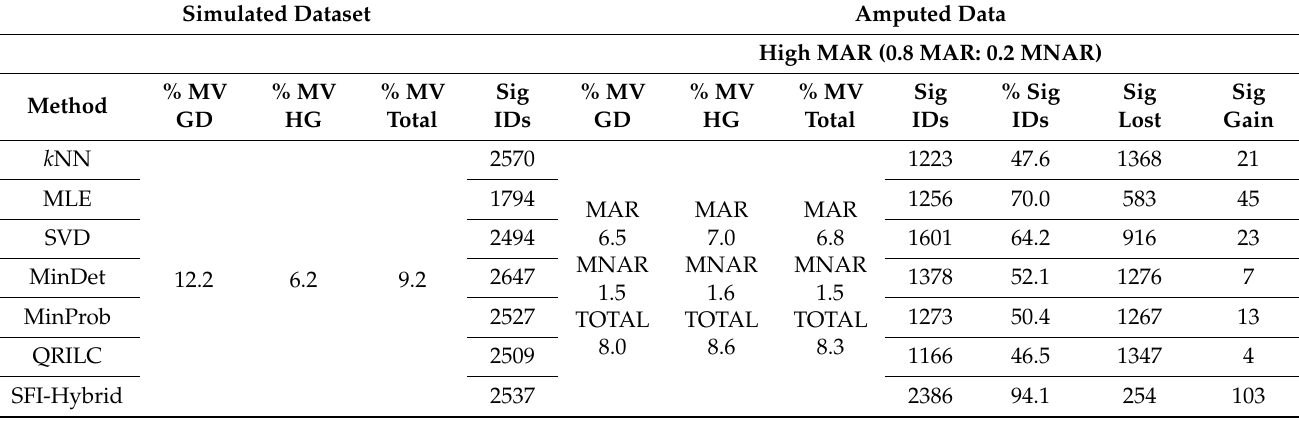
Table 1. Metrics for simulated and one amputed dataset by imputation method. MDA-MB-468 data were simulated as described in the methods section, and shown is the number of differentially expressed (DE) proteins (Sig IDs, q -value < 0.05) and the percentage of missing values (% MV) by treatment group (Note: the total number of potential observations in the dataset is 3807 proteins × 6 or 22842). The amputed metrics are from the High MAR instance, where the % Sig IDs is the percentage of the original Sig IDs captured after imputation and DE analysis. GD = glucose deprivation treatment group, HG = high